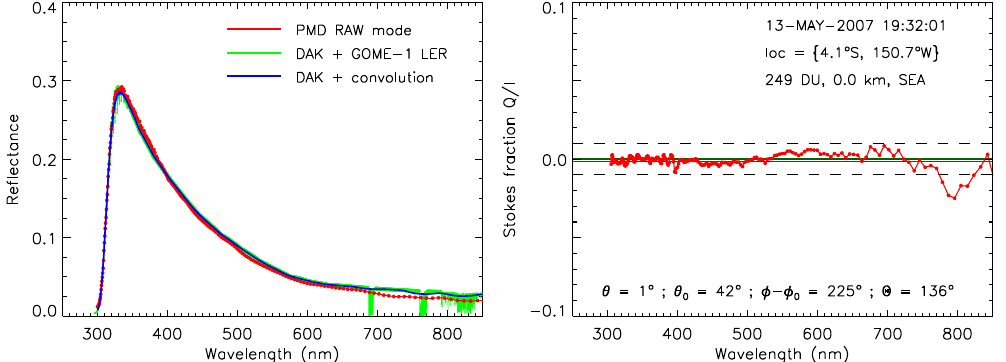
Figure 6. Left: reflectance spectrum measured by GOME-2 for a special geometry case over the ocean for which we expect Q/I to be